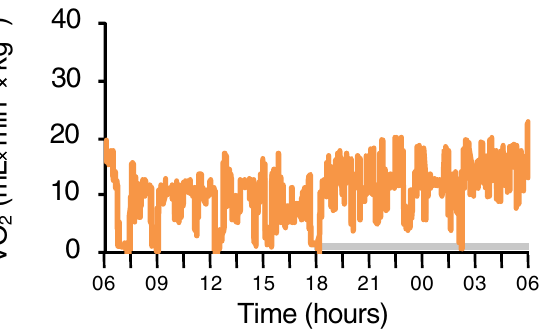
Figure 1. Detection of SDOC events during a 24-h monitoring of oxygen consumption in a subgroup of epileptic rats. Oxygen consumption ( ⩒ O 2 ) (light period from 06:00 am to 6:00 pm) was measured using respiratory thermochemistry. Grey bar above each x-axis indicates the dark period. A single profile was observed in control rats ( A ), while two distinct profiles were distinguished in epileptic rats ( B , C ). The first profile was similar to that observed in control rats ( B ), the second one was characterized by several episodes of sharp decrease in oxygen consumption (SDOC) (C), occasionally reaching zero. These SDOC events were only observed in epileptic rats, thereby dichotomizing two groups of epileptic rats (EPI/SDOC + and